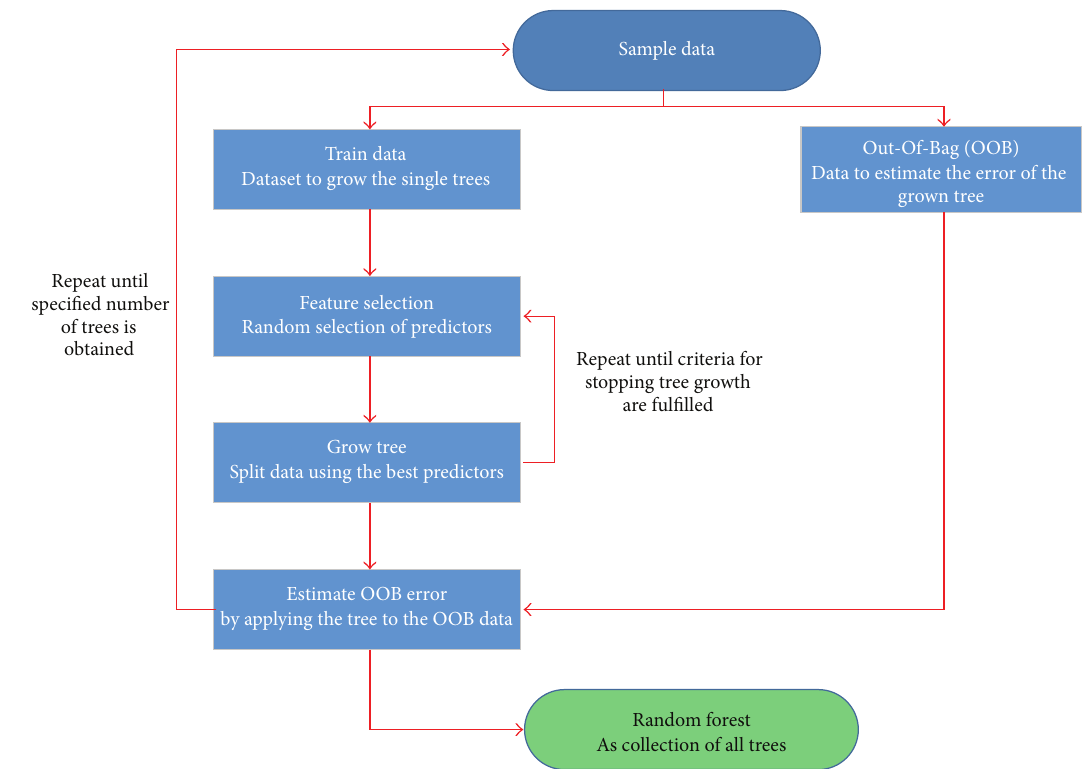
Figure 3: Random forest algorithm process